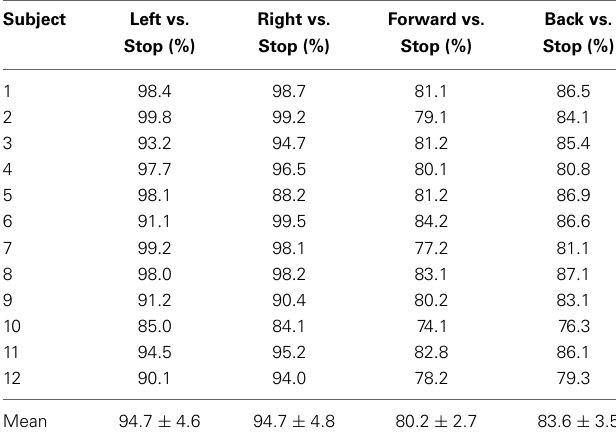
Table 2 | Classification accuracies: four control command accuracies of 12 subjects for left vs. stop, right vs. stop, forward vs. stop, and backward vs.